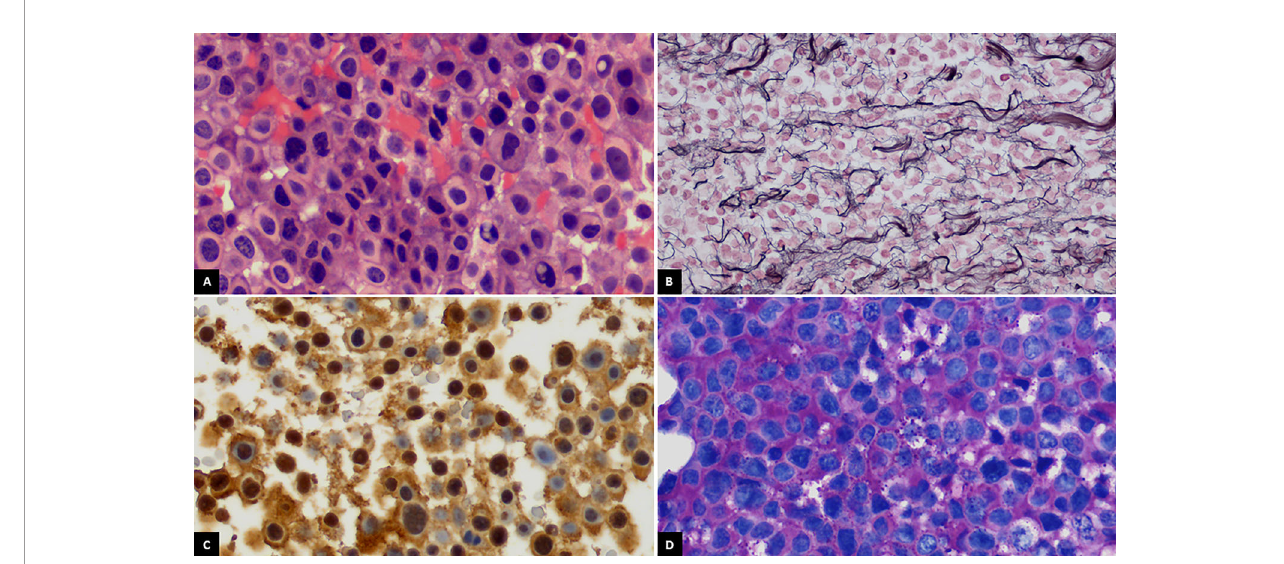
FIGURE 1 | (A) Crooke cells exhibiting wide glassy pale eosinophilic cytoplasm with intranuclear or perinuclear vacuoles (H&E, ×400). (B) Breakdown of reticulin network in the lesion (Gordon ’ s reticulin, ×400). (C) ACTH cytoplasmic immunoreactivity at the periphery of the cell (ACTH, ×400). (D) Periodic acid-Schiff (PAS) positivity staining stronger at the periphery of the cell